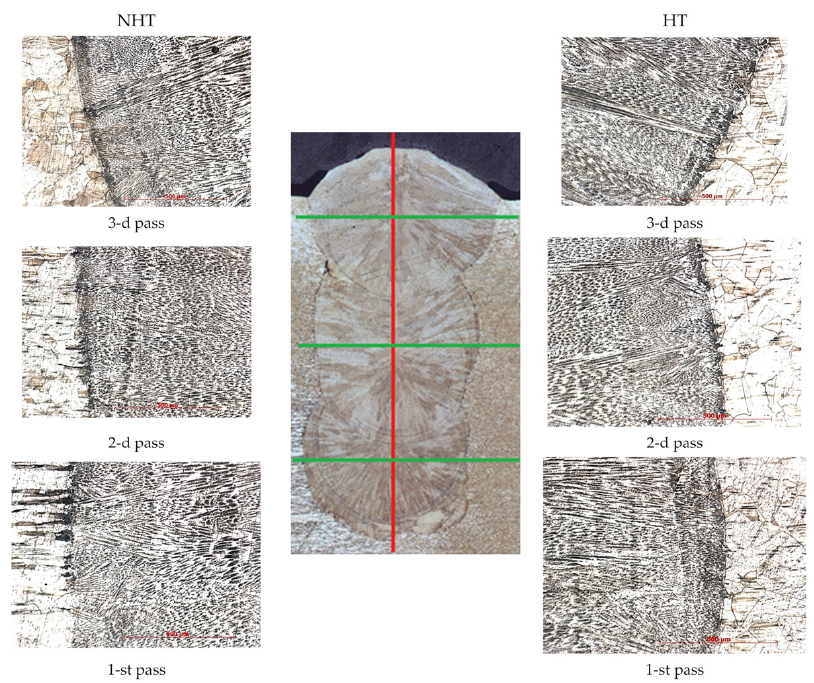
Figure 9. The weld seam macrostructure is in the center ; the transition line from the base metal to the middle of 1, 2, and 3 passes of NHT sample—on the left ; and the transition line from the base metal to the middle of 1, 2, and 3 passes of HT sample—on the right